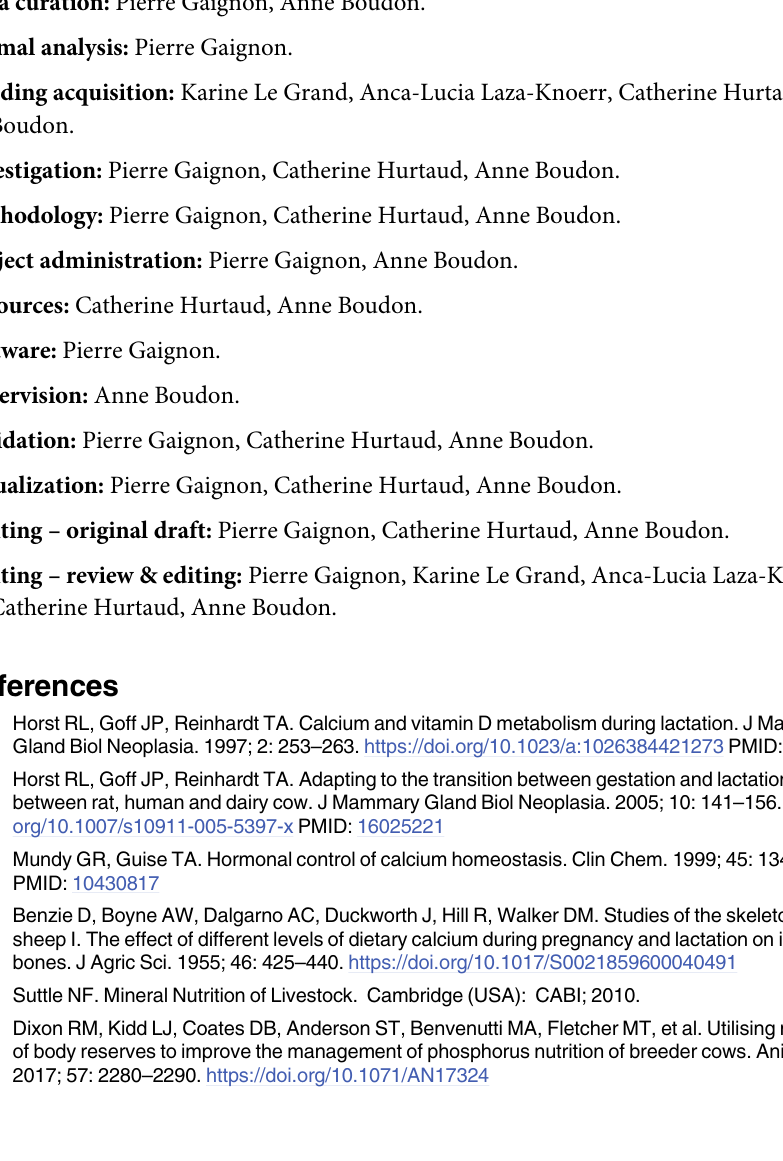
S1 Table. Estimated adjusted means ( ± Standard errors of the means) of all studied vari- ables according to the treatment and the week of